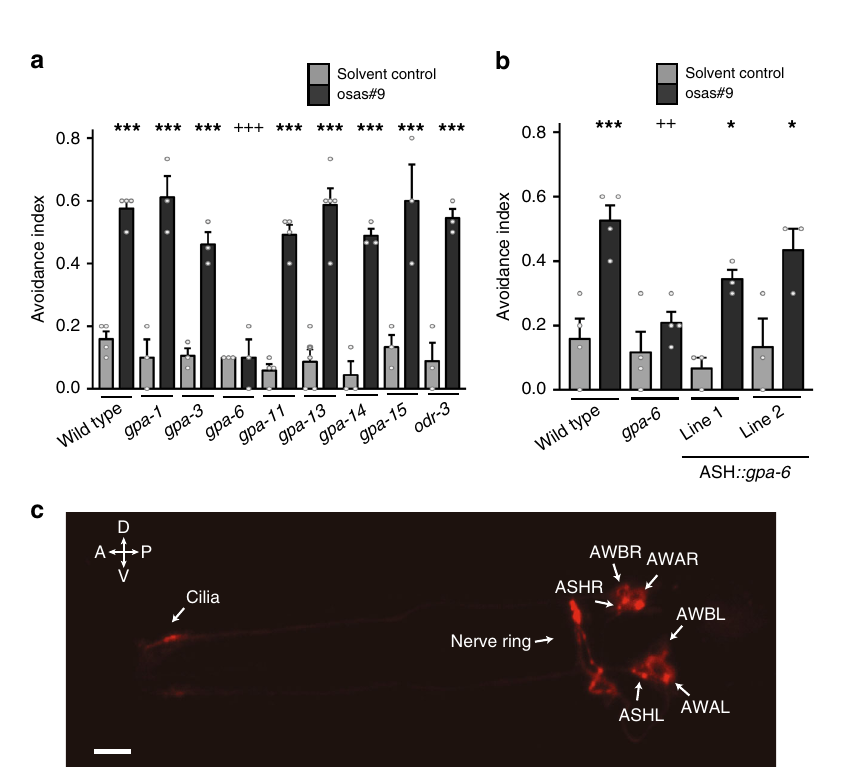
Fig. 6 GPA-6 functions in ASH sensory neurons to mediate osas#9 response. a Screen of mutations in G α subunits resulted in identi fi cation of the G α subunit, gpa-6 , which was defective in avoidance response to osas#9, n ≥ 3 trials. b Expression of gpa-6 in ASH neurons using nhr-79 promoter reconstituted avoidance response similar to wild-type animals, n ≥ 3 trials. c gpa-6 localizes to the soma and cilia in ASH neurons. Translational fusion of the entire gpa-6 genomic region displayed localization of the subunit to the soma of AWA, AWB, and ASH neurons. In addition, we also observed ciliary localization in ASH neurons (×40 magni fi cation, scale bar denotes 10 µ m). Data presented as mean ± S.E.M; * p < 0.05, ** p < 0.01, *** p < 0.001. One factor